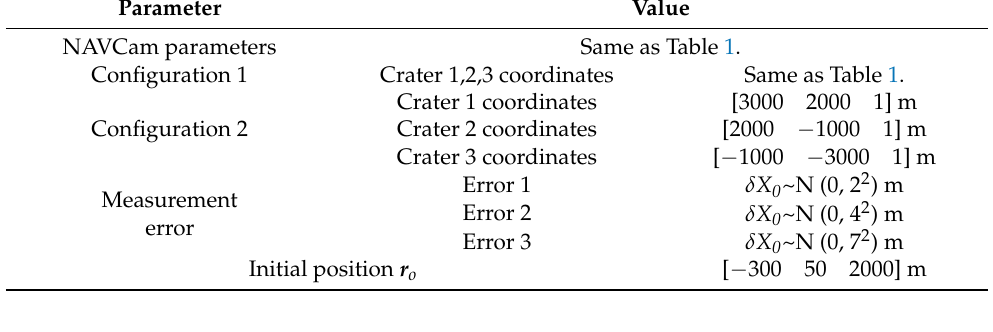
Table 2. Torus-OPNAV Monte Carlo simulation conditions.